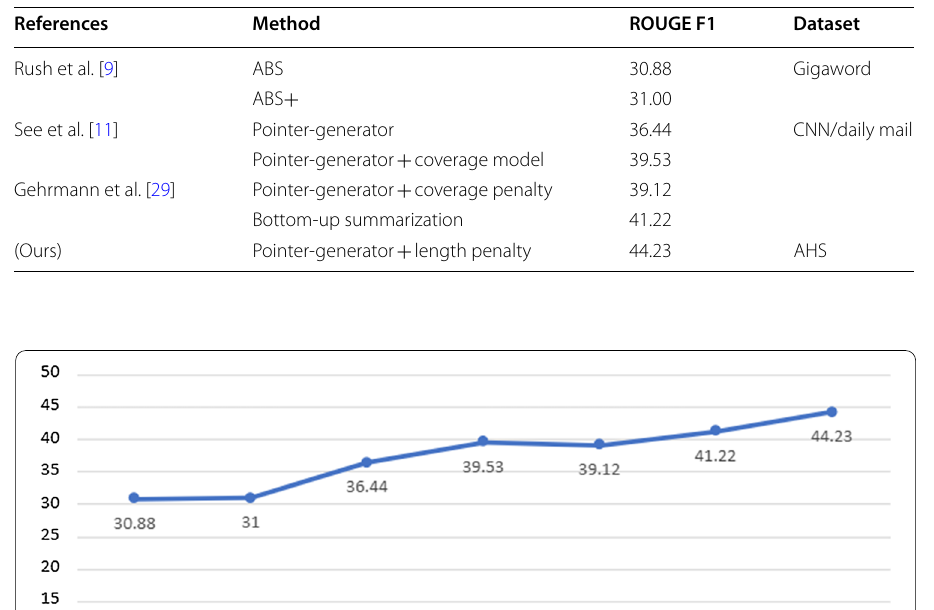
Table 5 Results of abstractive summarizers on different datasets